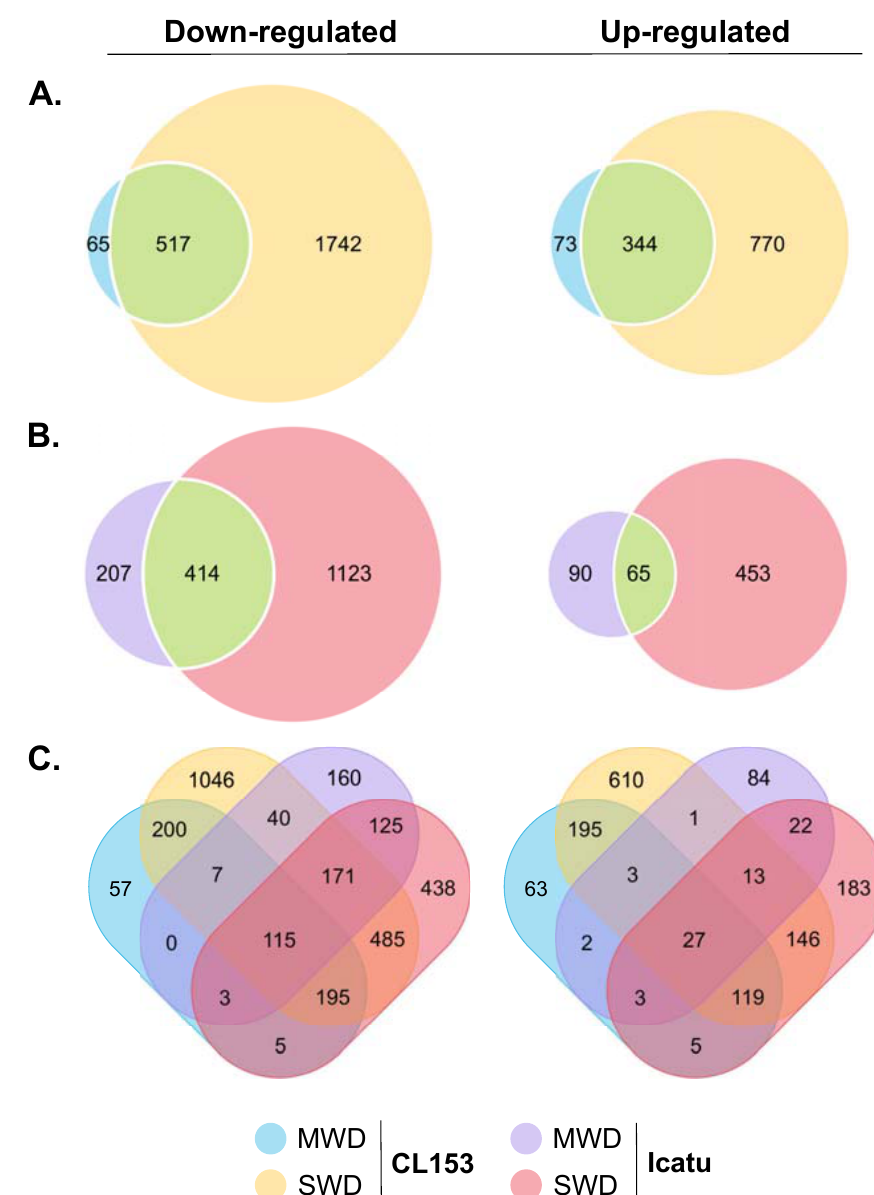
Figure 2. The total number of differentially expressed genes (DEGs) found in Coffea arabica cv. Icatu (Icatu) and C. canephora cv. Conilon Clone CL153 (CL153) plants submitted to moderate water deficit (MWD) or severe water deficit (SWD) in comparison to well-watered plants. ( A ) Number of DEGs found in CL153 that are specific to the MWD treatment (blue), specific to the SWD treatment (yellow), and commonly found in both water deficit treatments (green) being down-regulated ( left ) or right-regulated ( right ). ( B ) Number of DEGs found in Icatu that specific of the MWD treatment (purple), specific of the SWD treatment (pink) or commonly found in both water deficit treatments (green) being down-regulated ( left ) or right-regulated ( right ). ( C ) Distribution patterns of DEGs considering the two genotypes together for down-regulated ( left ) or right-regulated ( right ) DEGs.